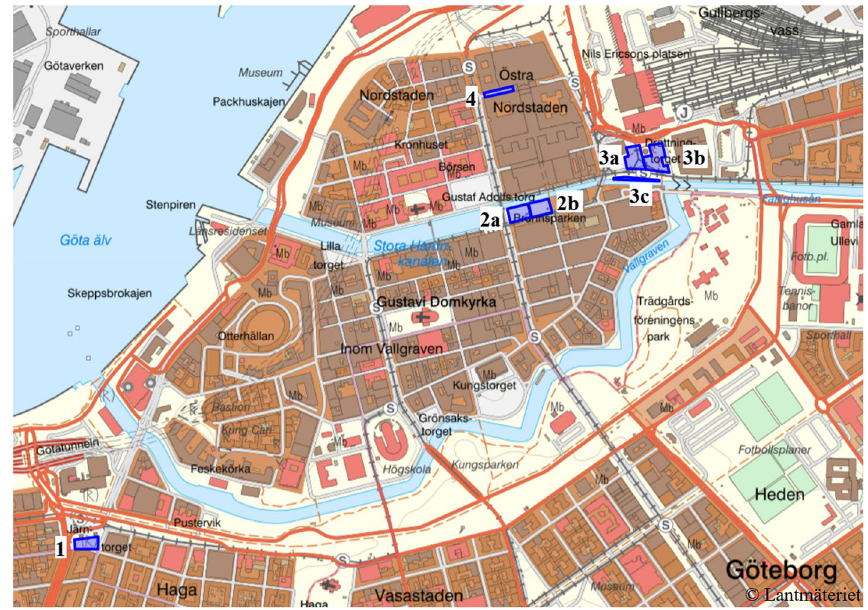
Fig. 2 Overview map showing observation sites 1–4 in the city centre of Gothenburg, Sweden [60]. Sites are outlined by a blue line. Site 1 square Järntorget , site 2 public square Brunnsparken , site 3 =